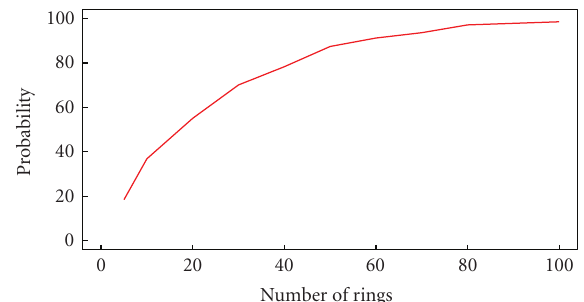
Figure 8: Simulated probability of hitting a transition region.